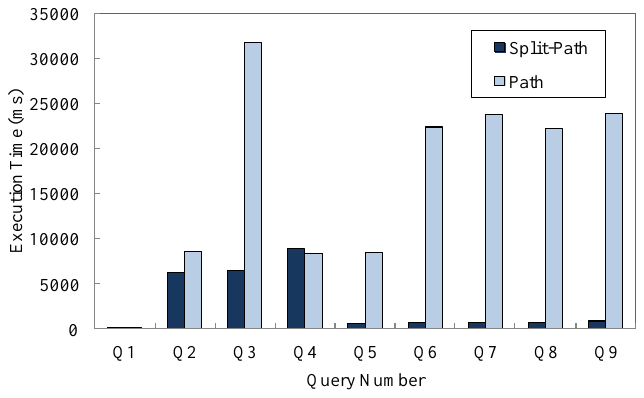
Figure 6. Query performance